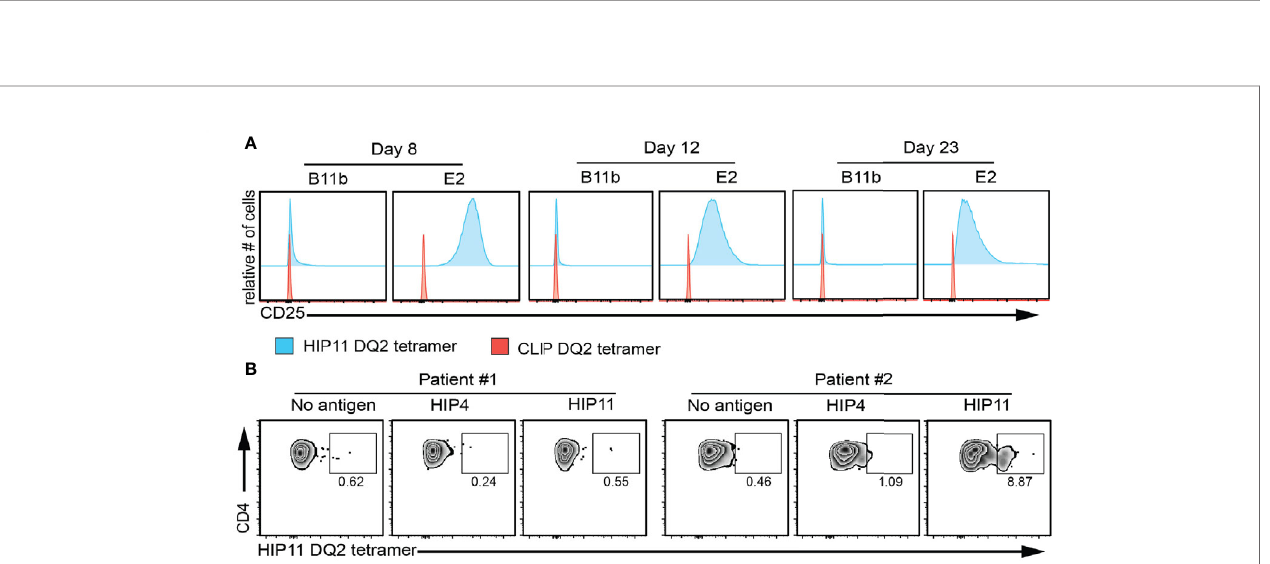
FIGURE 5 | HIP11/DQ2 tetramer stains the E2 T cell clone and PBMCs from a T1D patient. (A) The E2 or B11b T cell clones were stimulated with HIP11 or HIP4 respectively and an irradiated autologous EBV-transformed B cell line. T cells were then maintained in culture and harvested at 8, 12 and 23 days post-stimulation and stained with the DQ2/HIP11 tetramer (blue histograms) or DQ2/CLIP tetramer (red histograms), CD4, and a fi xable viability dye. Tetramer staining was assessed by fl ow cytometry by gating on live, CD4 + cells. Data are representative of two independent experiments. (B) PBMCs from two DQ2+ patients were isolated, stained with CFSE and cultured with medium only, HIP4, or HIP11. After 10 days, cells were harvested and stained with the DQ2/HIP11 tetramer, anti-CD4 and anti-CD25 antibodies, and a fi xable viability dye before fl ow cytometry analysis. Gates were set on live, CD4 + CD25 + CFSE low events and the percentage of tetramer positive events is